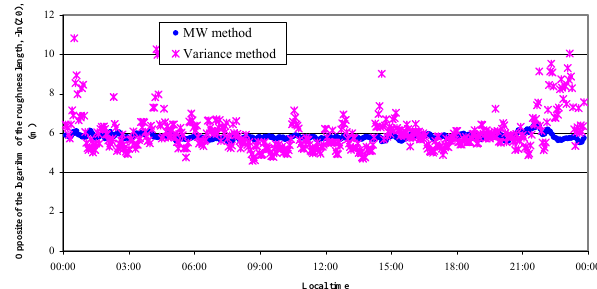
variance method (Plot CT, 25 July 1997)